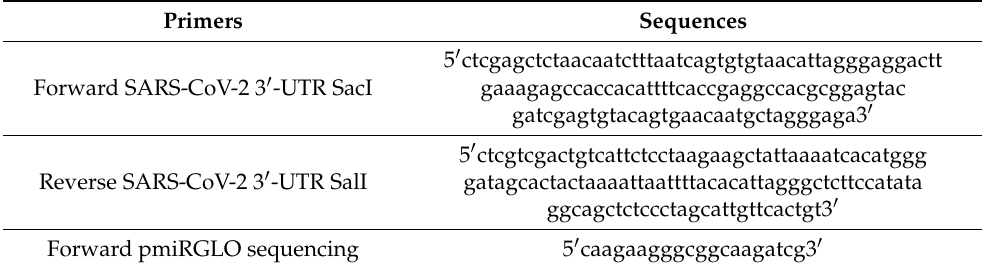
Table 4. Primers used for subcloning of SARS-CoV-2 3 (cid:48) -UTR. Primers Sequences Forward SARS-CoV-2 3 (cid:48) -UTR